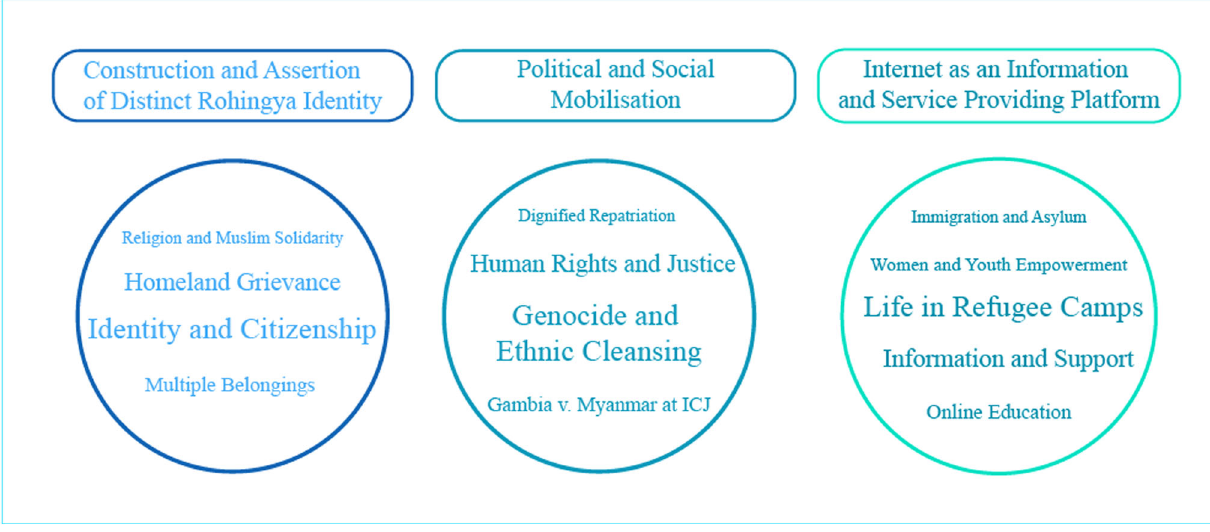
Fig. 2 Major discussion themes on web platforms. Three major components of Rohingya diaspora ’ s digital